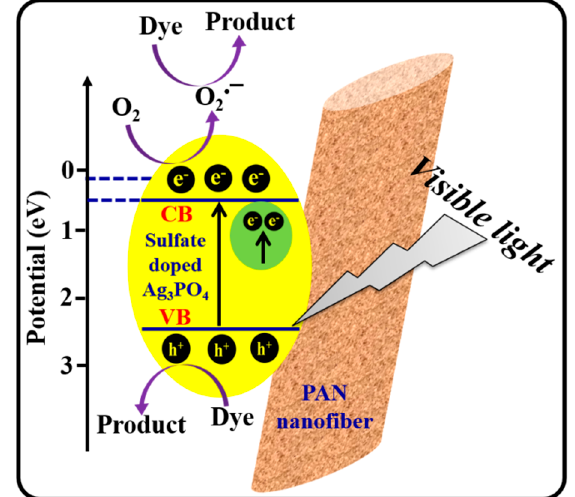
Figure 10. Schematic illustration for the degradation of dye by sulfate-doped Ag 3 PO 4 / PAN under visible light irradiation.